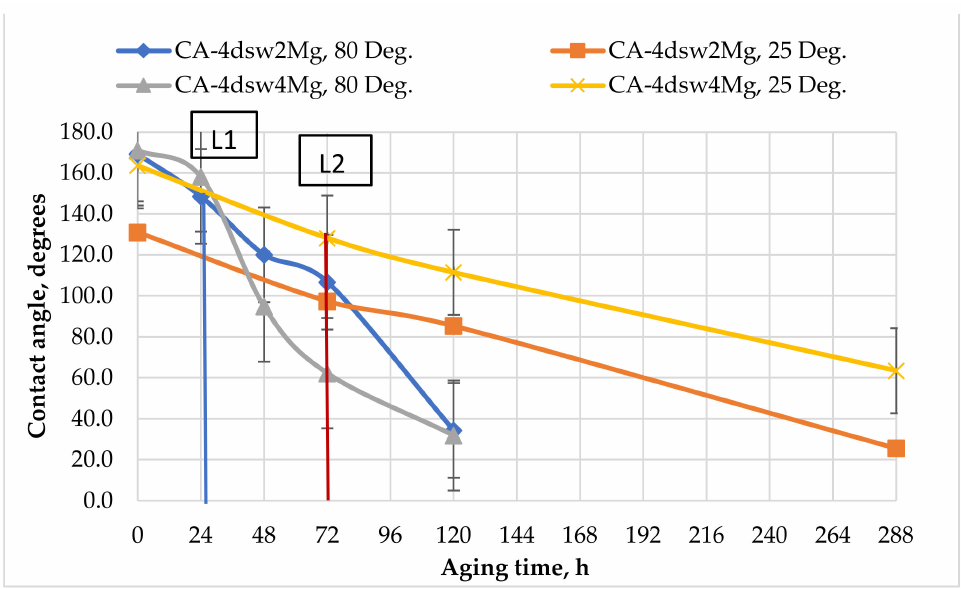
Figure 12. Effect of active ions (Mg 2+ ) on the performance of EW and EW-NF, at room temperature and an elevated temperature of 80 ◦ C.